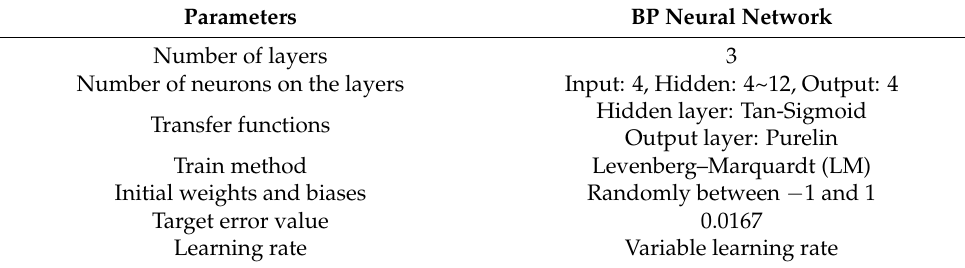
Table 2. The architecture and training parameters of the BP neural network.